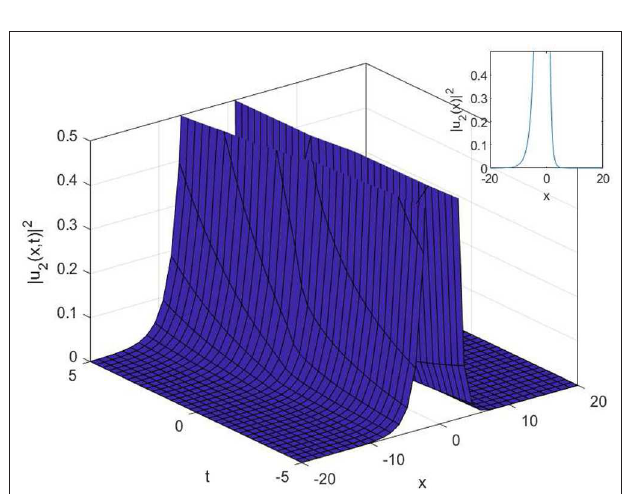
FIGURE 2 | 3D, 2D, and contour surfaces of Equation (28) where γ 0.5, c 2 0.2, κ 0.4, α = = = =